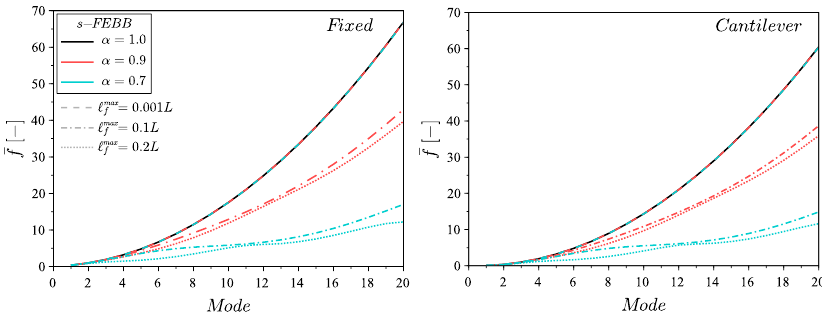
Figure 3. Dimensionless frequency ¯ f for the s-FEBB model for the fixed beam and cantilever beam = [ 0.001 L , 0.1 L , 0.2 L ] compared to the results of CEBB model (s-FEBB for α = [ 0.9, 0.7 ] and (cid:96) max f model with α = 1.0).